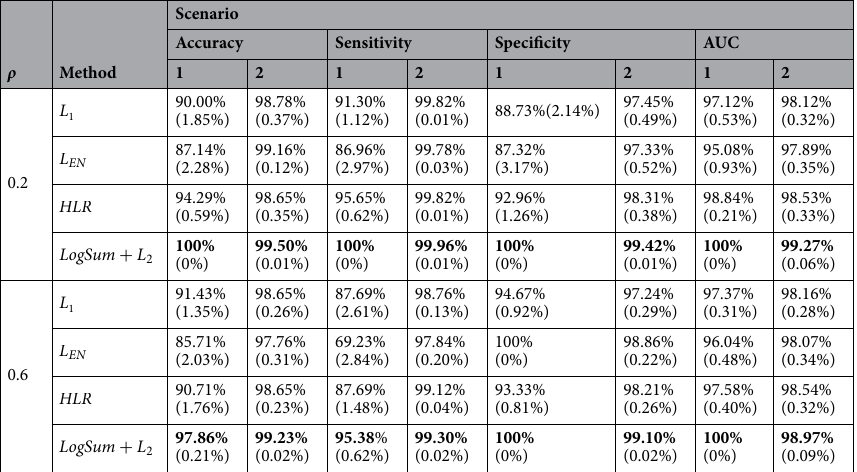
Table 1. Training results of different methods on the simulated datasets. Numbers in parentheses are the standard deviations and the best results are highlighted in